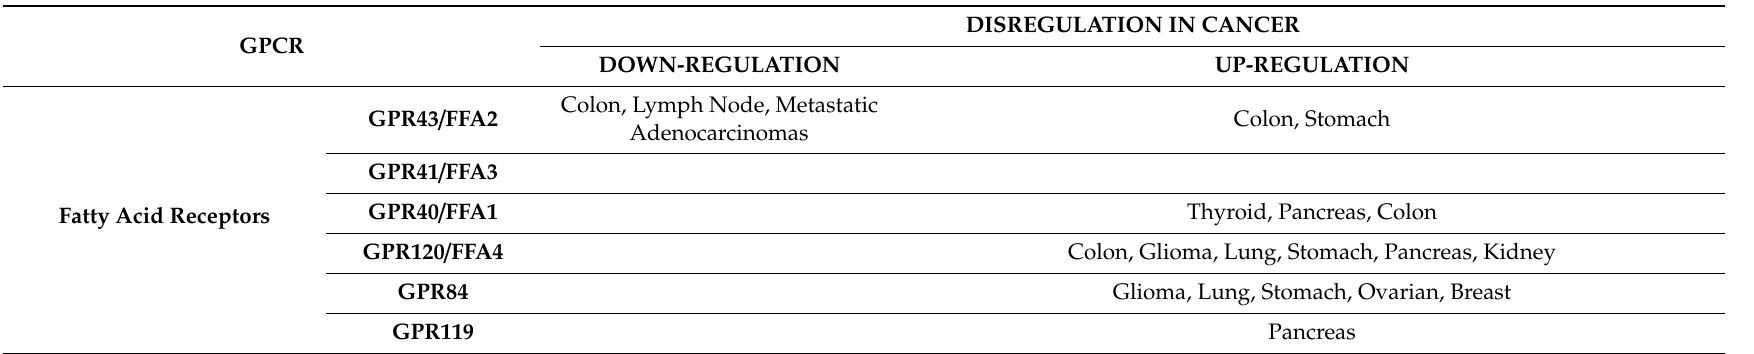
Table 2. Di ff erential expression of metabolite sensing-GPCRs in several types of cancer. This table indicates the neoplasias where an up-regulated or a down-regulated GPCR expression has been detected in human tumoral samples compared with the corresponding healthy tissues. (FFA, free fatty acid; HCA, hydroxycarboxylic acid; TA, trace amines; CaSR, calcium sensing receptor; TAAR1, trace amine associated receptor